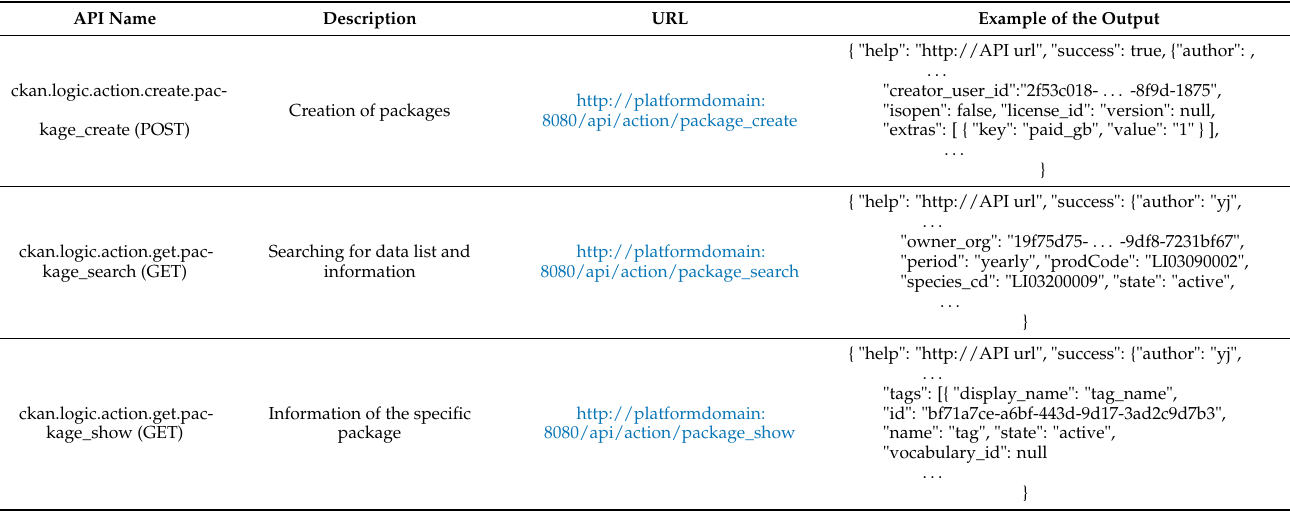
Table 6. The list of developed